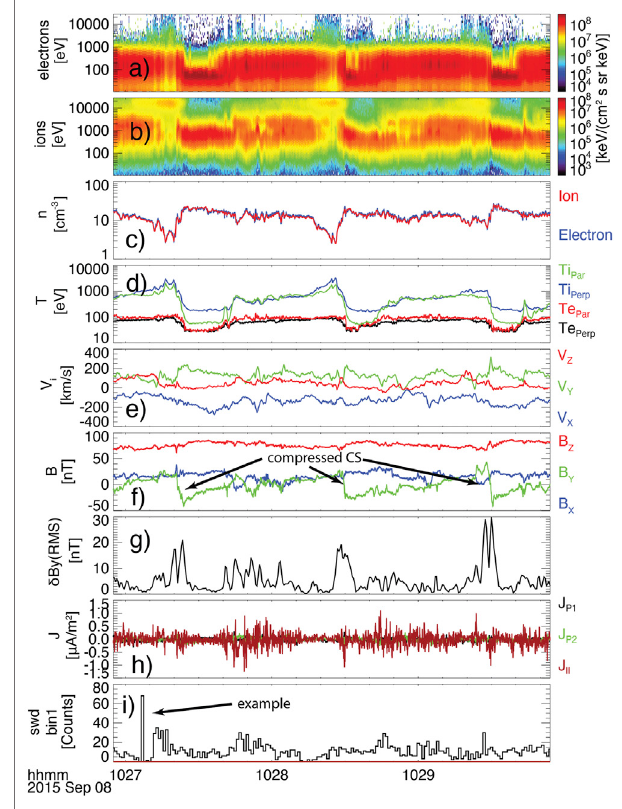
FIGURE 2 | MMS data showing two periods of KHI during the September 8, 2015 event. (A) electron omni-directional energy spectra, (B) ion omni-directional energy spectra, (C) electron and ion number density, (D) electron and ion temperature perpendicular and parallel to the background magnetic fi eld, (E) ion bulk velocity in GSE coordinates, (F) magnetic fi eld vector in GSE coordinates, (G) dB Y (RMS), (H) the electric current density in fi eld-aligned coordinates, (I) swd bin 1